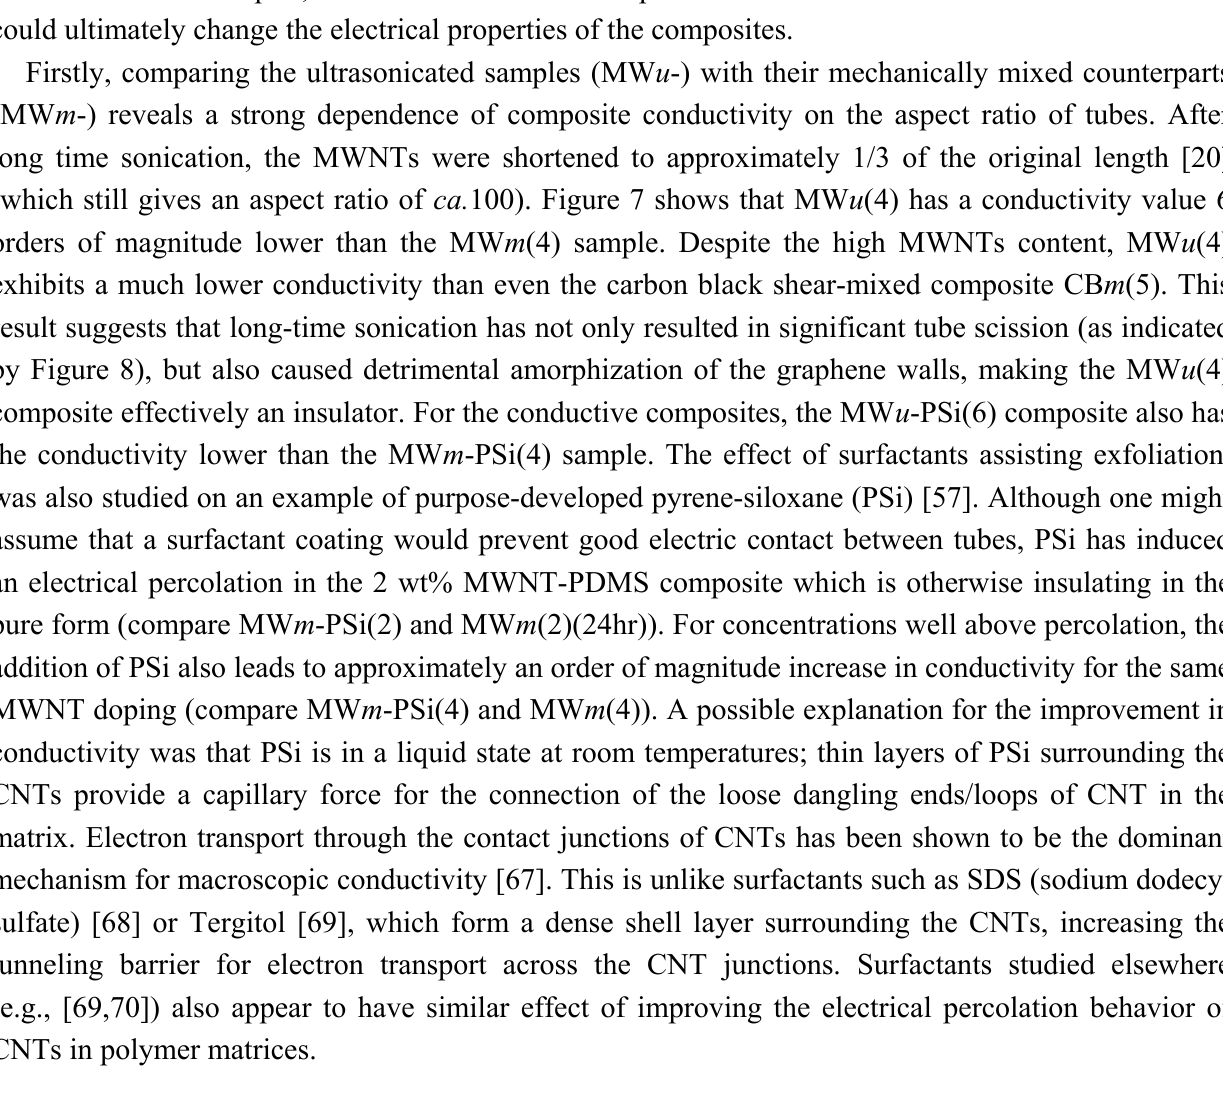
Figure 8. TEM images of the MWNTs embedded in PDMS, after a sonication treatment of 1 h and 10